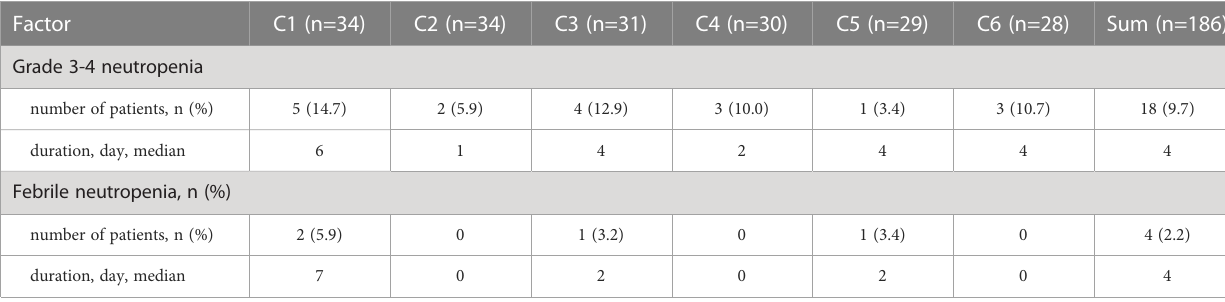
TABLE 2 Grade 3-4 neutropenia and Febrile